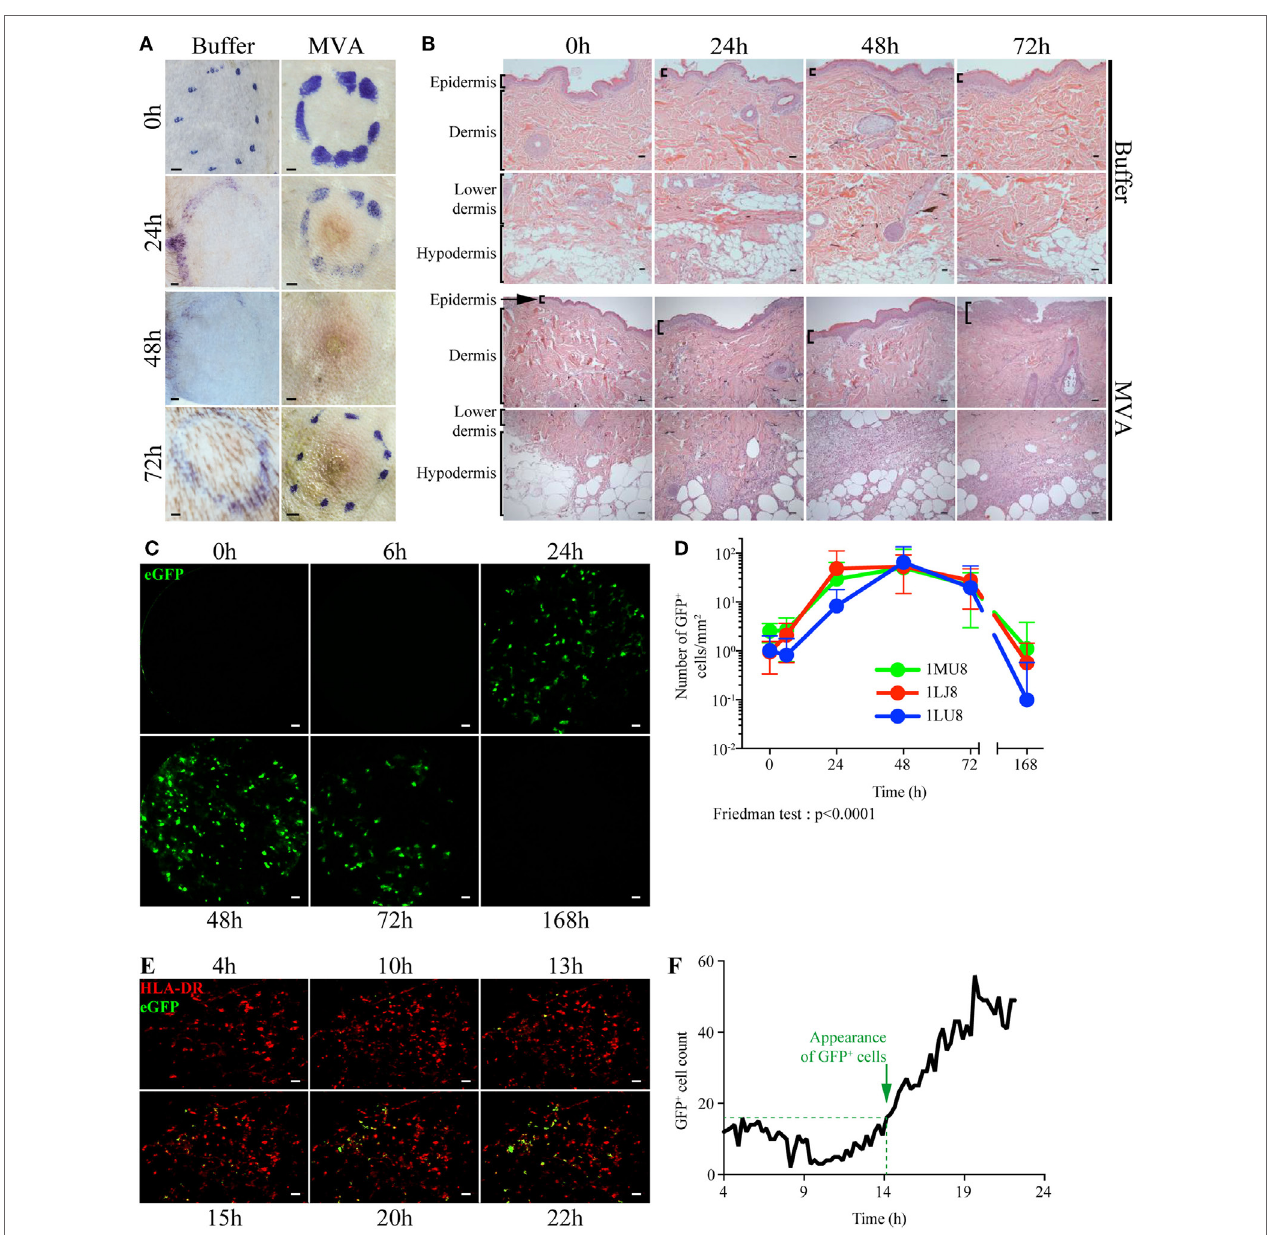
FigUre 1 | Dynamics of local inflammation and infection after intradermal injection of rMVA. (a) Image of the skin before and after Buffer or rMVA injection. Scale bars correspond to 2 mm. (B) HE staining of transversal sections of non-human primate skin biopsies taken at the site of injection before or 24, 48, or 72 h after Buffer or rMVA injection. Scale bars correspond to 100 µm. (c) Representative images recorded by in vivo confocal endo-microscopy. Recordings were performed at the site of injection in the dermis (at a depth of 100 ± 35 µm in the skin) with a probe detecting fluorescent signals after excitation at a wavelength of 488 nm. Green fluorescence corresponds to the production of GFP in rMVA-infected cells. Scale bars correspond to 50 µm. (D) Kinetic profile of GFP + cells in the skin after rMVA injection. The graph represents the mean ± SD of the number of GFP + cells/mm 2 in the 50 frames with the most GFP + cells. (e) Representative images from time-lapse video-confocal microscopy of HLADR + (in red) and GFP + (in green) cells after i.d. injection of rMVA. Skin biopsies were observed for 22 h p.i. Acquisition was performed at a depth of 50–150 µm in the skin (dermis) corresponding to a stack of 10 images. Visual representations correspond to a two-dimensional visualization of this stack at the indicated time p.i., after cropping the region of interest. Scale bars correspond to 20 µm. (F) Kinetic profile of GFP + cell detection in the dermis during the first 22 h p.i. The graph indicates the number of GFP + cells counted for each image (1 image each 15 min). Green objects between 200 and 4,000 µm 3 were considered to be GFP + cells. The approximate time of appearance of non-background GFP + cells is indicated with the dotted line at 14–15 h